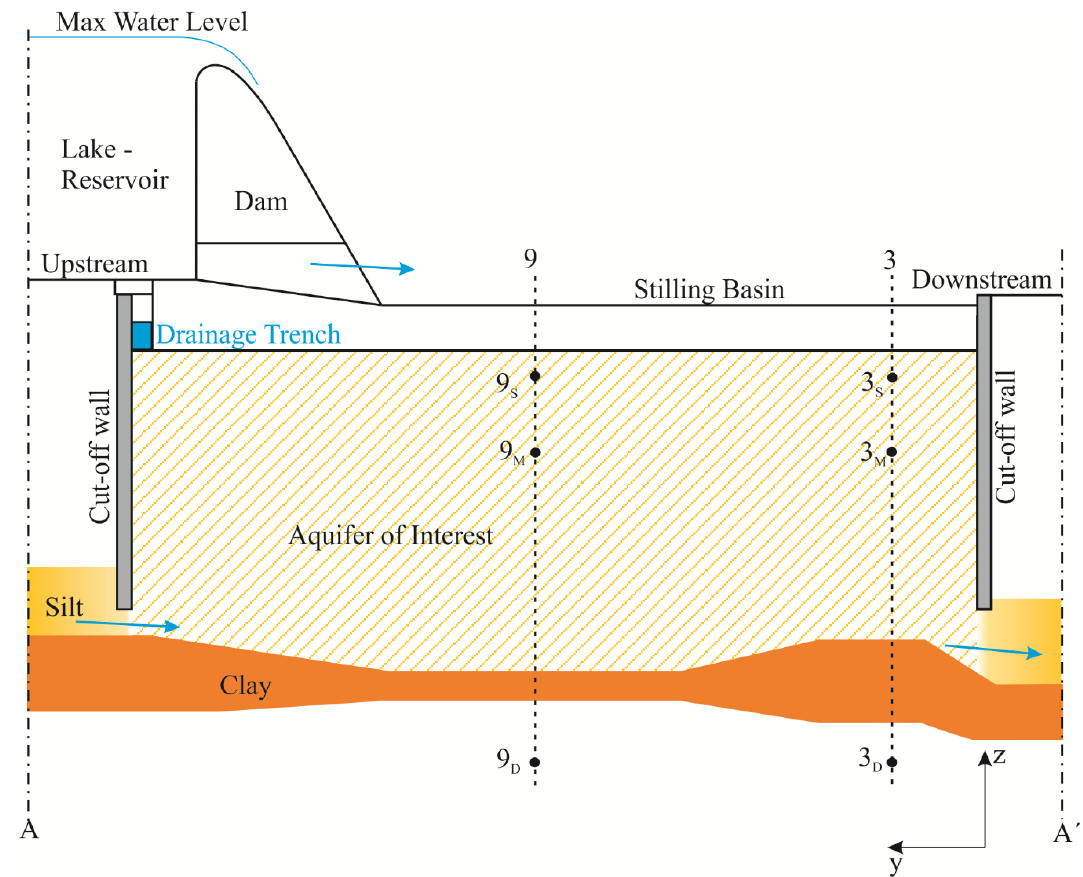
Figure 2. Sketch view of the vertical cross section (AA’) of the investigated area with the indication of the aquifer of interest. Figure not to scale. Monitoring wells no. 9 and no. 3 with the indication of the observation depth: Shallow (S), medium (M) and deep (D). The plan view is shown in Figure 1.